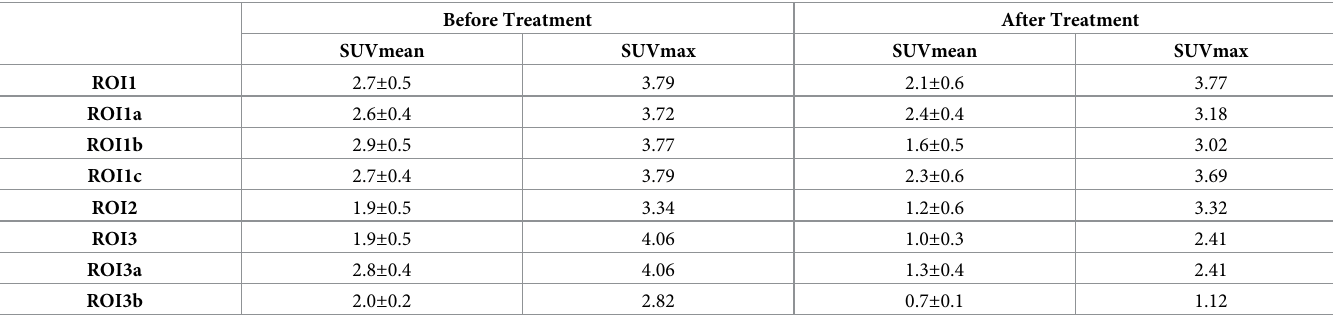
Table 1. SUV results before and after treatment for all identified ROIs.